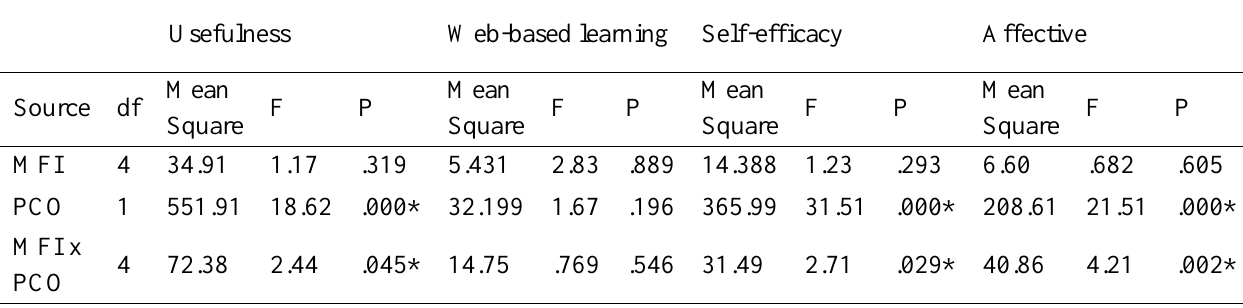
Table 11 The Two-Way ANOVA Results on the Web Attitude depending on Monthly Family Income and PC Ownership Usefulness Web-based learning Self-efficacy Affective